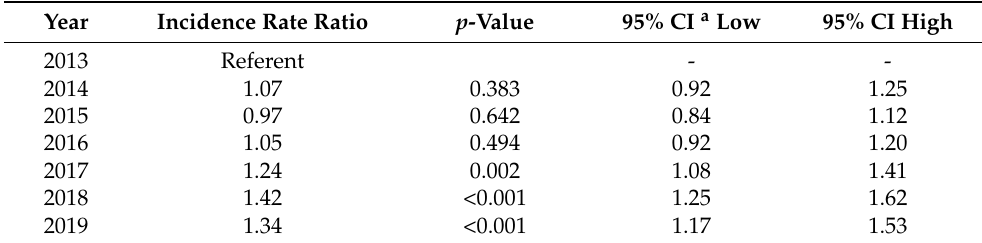
Table 2. Results of a Poisson regression model showing differences between years in the number of antimicrobials to which an E. coli isolate is resistant.